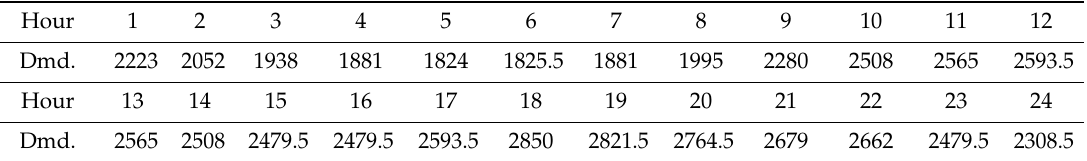
Table 8. 24-hour load demand for 26-unit